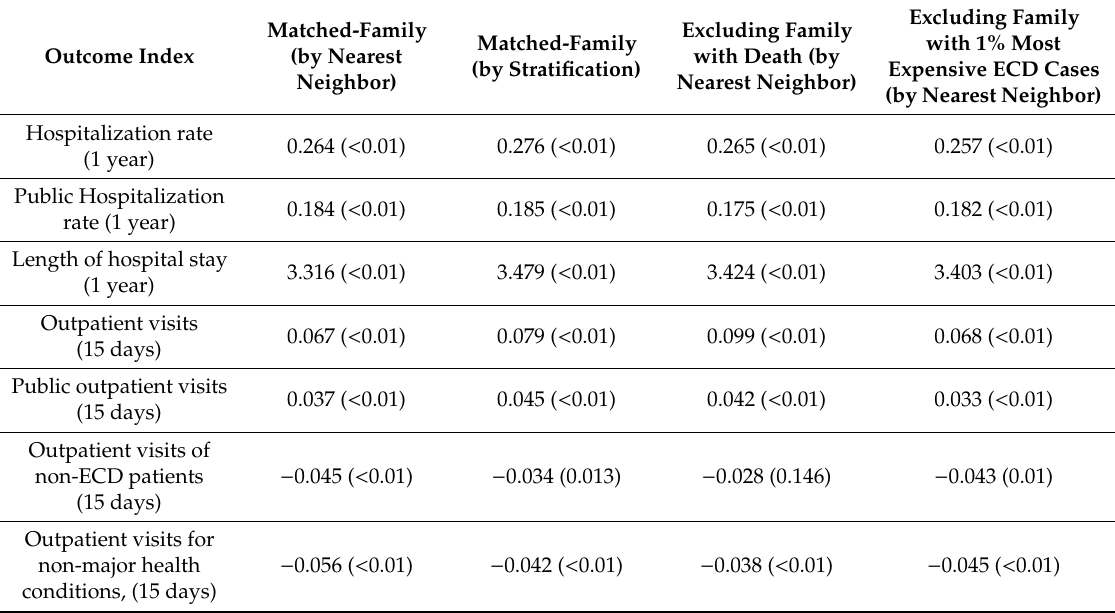
Table 2. E ff ects of elderly chronic disease (ECD) on family health service utilization in China. (Unit: per family